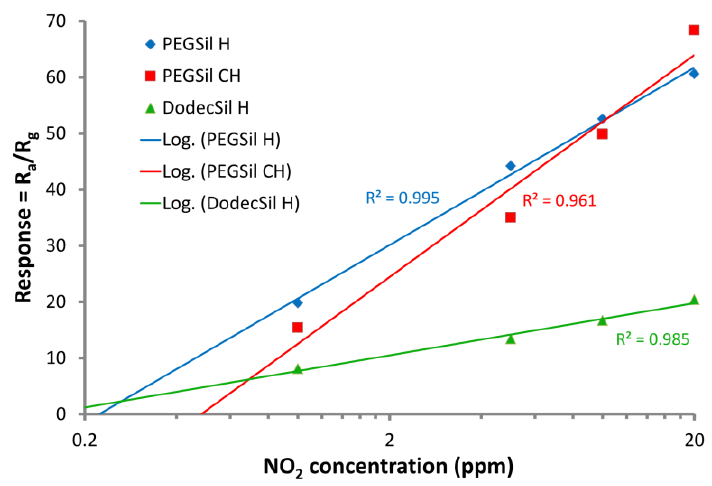
Figure 5. Sensors ’ calibration curves in a semi-logarithmic scale for an operating temperature Figure 5. Sensors’ calibration curves in a semi-logarithmic scale for an operating temperature = 100 ◦ C. = 100 °C .